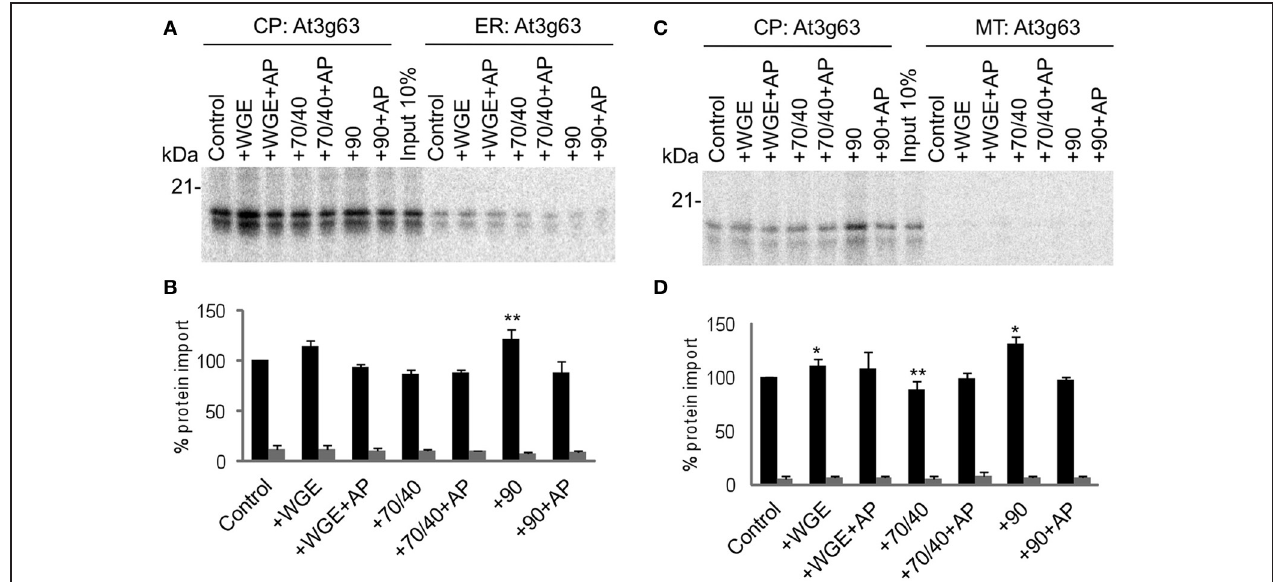
FIGURE 4 | At3g63 targets to chloroplasts efficiently and selectively under a wide range of cytosolic conditions. (A) Radio-labeled At3g63 protein derived from RNCs was incubated in a competitive targeting assay with chloroplasts (CP) and ER, with the addition of cytosolic components as indicated; control is buffer only, WGE is wheat germ extract, chaperones (Hsp) are indicated by their numbers (70/40 or 90), and AP represents apyrase treatment. Membranes were refractionated and washed with carbonate before analysis by SDS-PAGE. 10% of protein input is shown, and the protein molecular weight markers are indicated in kDa. (B) Quantification